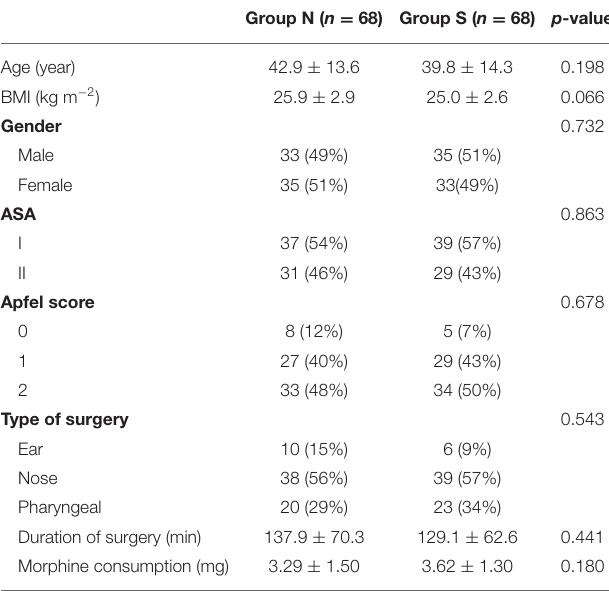
TABLE 1 | Patients and clinical characteristics. Data presented as mean ± SD or number